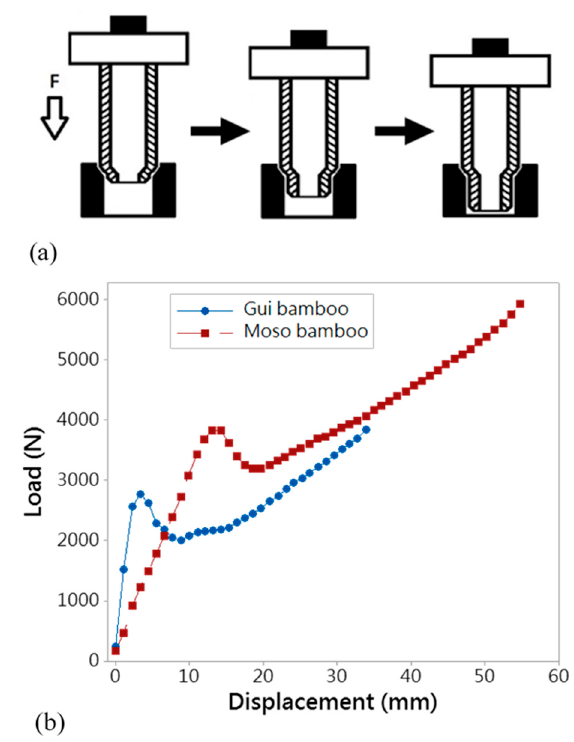
Figure 6. ( a ) Reducing process. ( b ) Typical load–displacement curves.